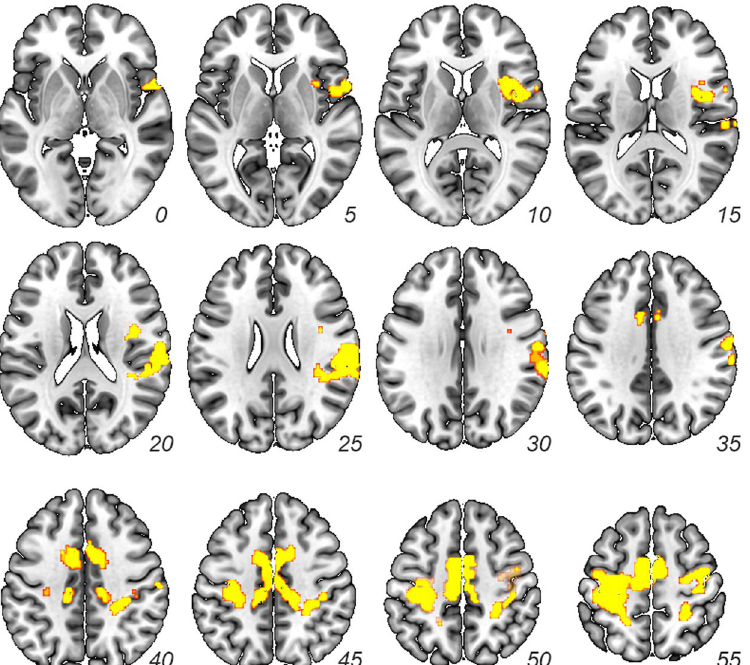
Figure 3. Repetition Enhancement. Results from whole-brain contrast of identical in-group, different in-group > out-group/in-group trials ( p < 0.001 corrected from p <